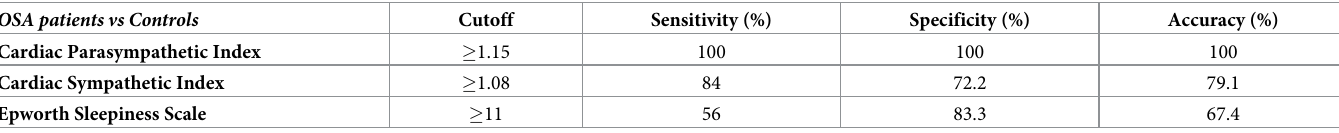
an individual basis (Fig 1A), whereas the cardiac sympathetic index showed an overlap of indi- vidual values between the participants from the two groups (Fig 1B). The Epworth Sleepiness Scale had a lower accuracy (67.4%) than the cardiac autonomic indexes in differentiating OSA patients from controls (Table 3). In the whole sample, Table 3. Performance of cardiac parasympathetic and sympathetic indexes and epworth sleepiness scale in differentiating OSA patients from controls. OSA patients vs